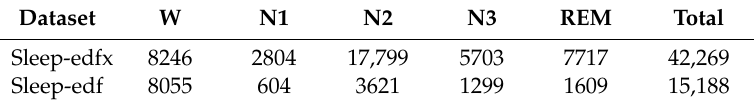
Table 1. Number of epochs of each stage in the datasets after